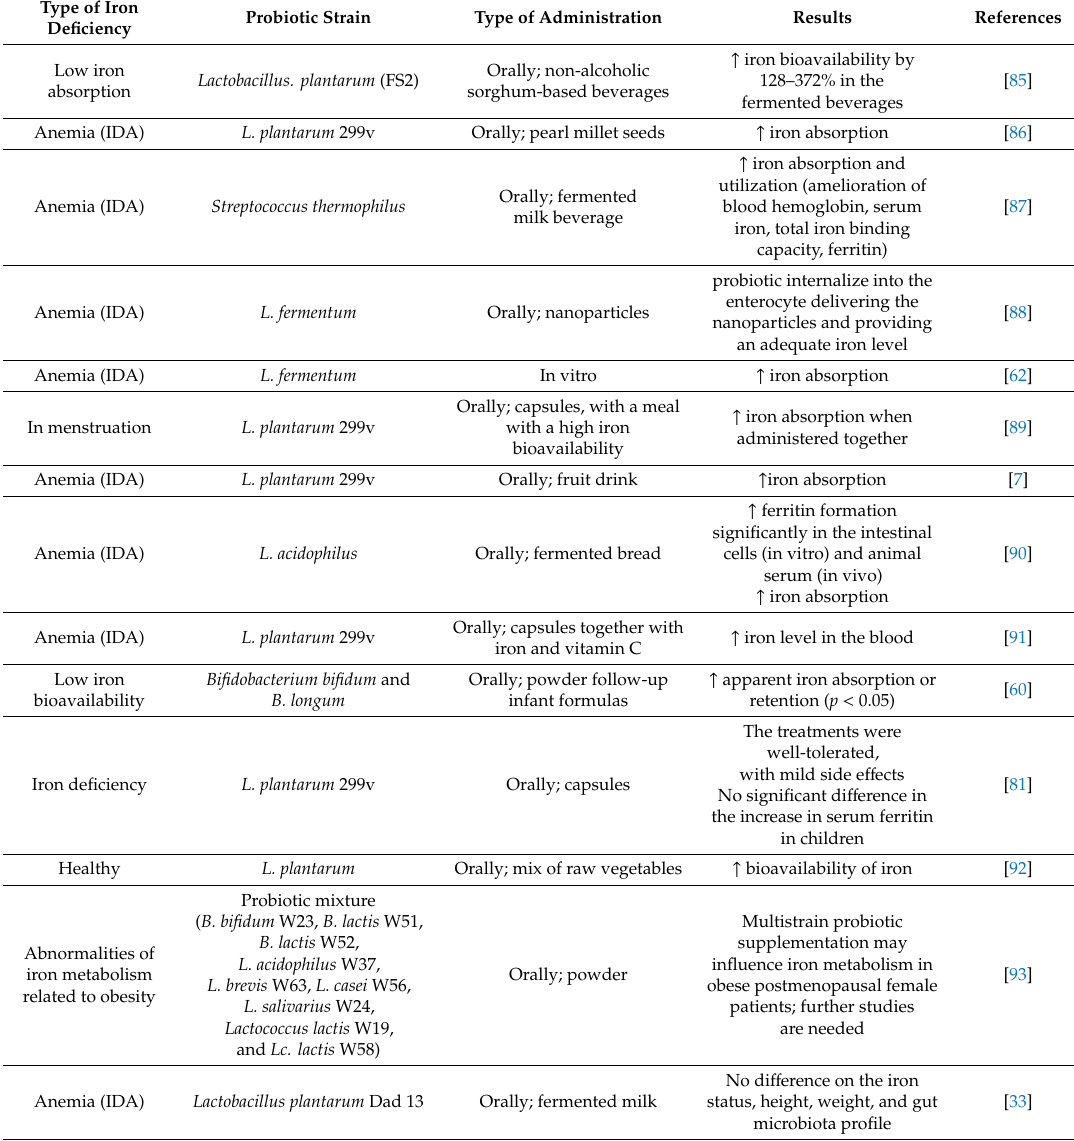
Table 1. Probiotic intake in di ff erent types of iron deficiencies and their e ff ect on the iron level in the organism. IDA, iron deficiency